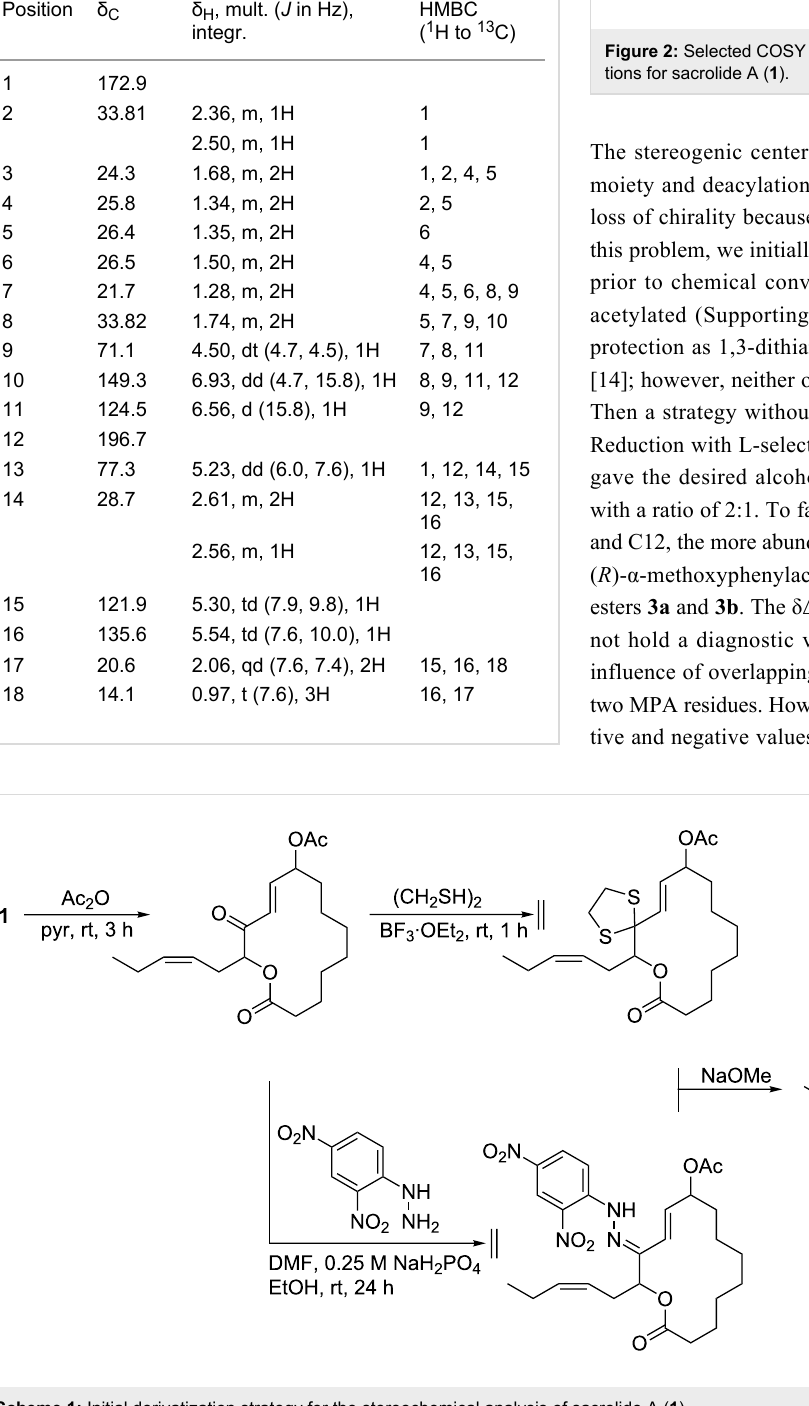
Table 1: 1 H (500 MHz) and 13 C (125 MHz) NMR data for sacrolide A ( 1 ) in CDCl 3 ( δ in ppm). Position δ C δ H , mult. ( J in Hz), integr.